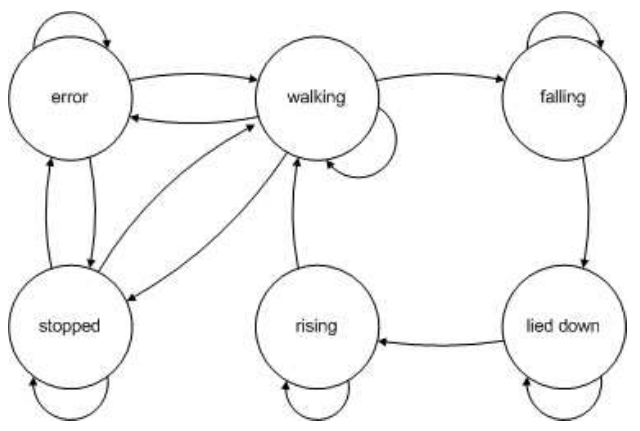
Figure 7. Structure of the HMM used in experiment